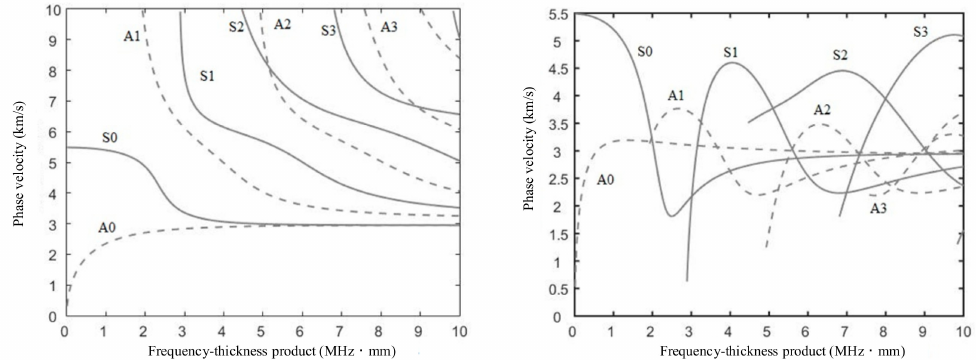
Figure 2. Phase velocity and group velocity dispersion curves for Lamb